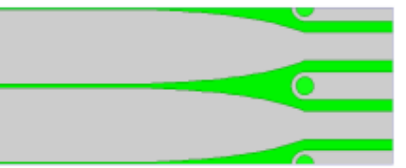
Figure 3: Quadruple Fin Line with resonance absorption.